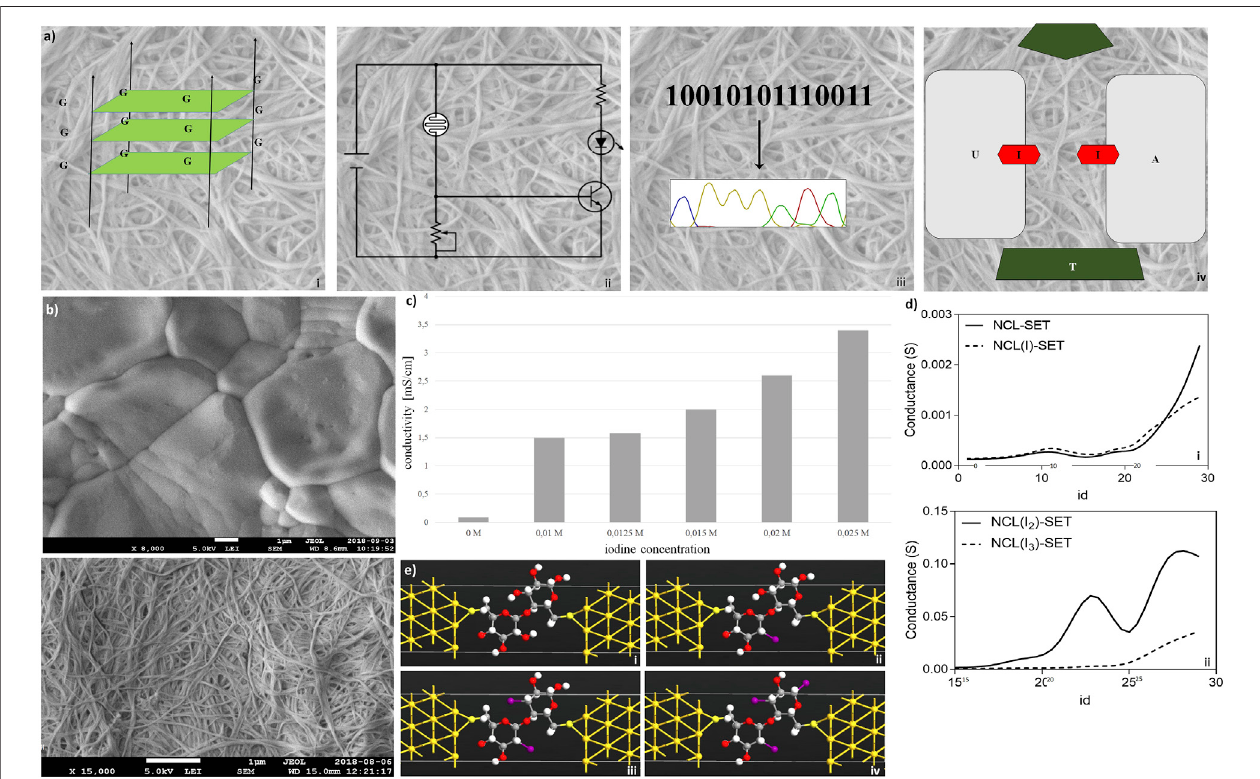
FIGURE 3 | Electronic features of nanocellulose. (A) Concept: nanocellulose can replace silicon, for example, introducing electronics and modifying enzymes: (i) G-wirequartets,allowingconductionofelectriccurrent; (ii) condenser/resistor,differentprintedelectronicscanbeapplied; (iii) sequencingresult,differentenzymesand DNA can be attached on the NC; and (iv) represents the introducing of SET. (B) Nanocellulose becomes conductive with iodine doping (0.025 M iodine) (Panel (i) ), untreated control is depicted in Panel (ii) . (C) Measured conductivities for the iodine treated nanocellulose. (D) Conductance curves (i,ii) calculated for the nanocellulose (NCL)-based SETs with and without iodine modi fi cation (I, I 2 , and I 3 atoms), consisting of gold (111) nano-electrodes and a subunit of nanocellulose molecule as a central element: NCL-SET, NCL(I)-SET, NCL(I 2 )-SET, and NCL(I 3 )-SET as molecular junctions. (E) In silico molecular illustration of nanocellulose (NCL)- based SETs with and without iodine modi fi cation (I, I 2 , and I 3 atoms): consisting of gold (111) nano-electrodes and a subunit of nanocellulose molecule as a central element. The nanocellulose-based SETs: NCL-SET (i) , NCL(I)-SET (ii) , NCL(I 2 )-SET (iii) , and NCL(I 3 )-SET (iv) as molecular junctions were designed using the Virtual NanoLab